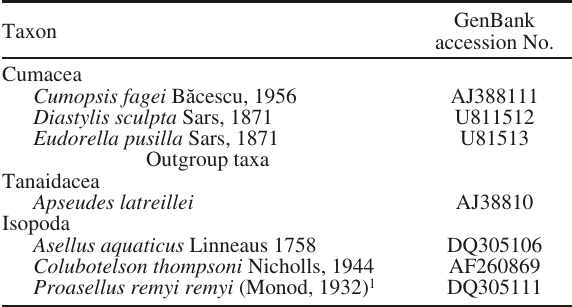
Table 2. – Cumacean sequences obtained from GenBank. 1 Subspe- cies remy described by Karaman